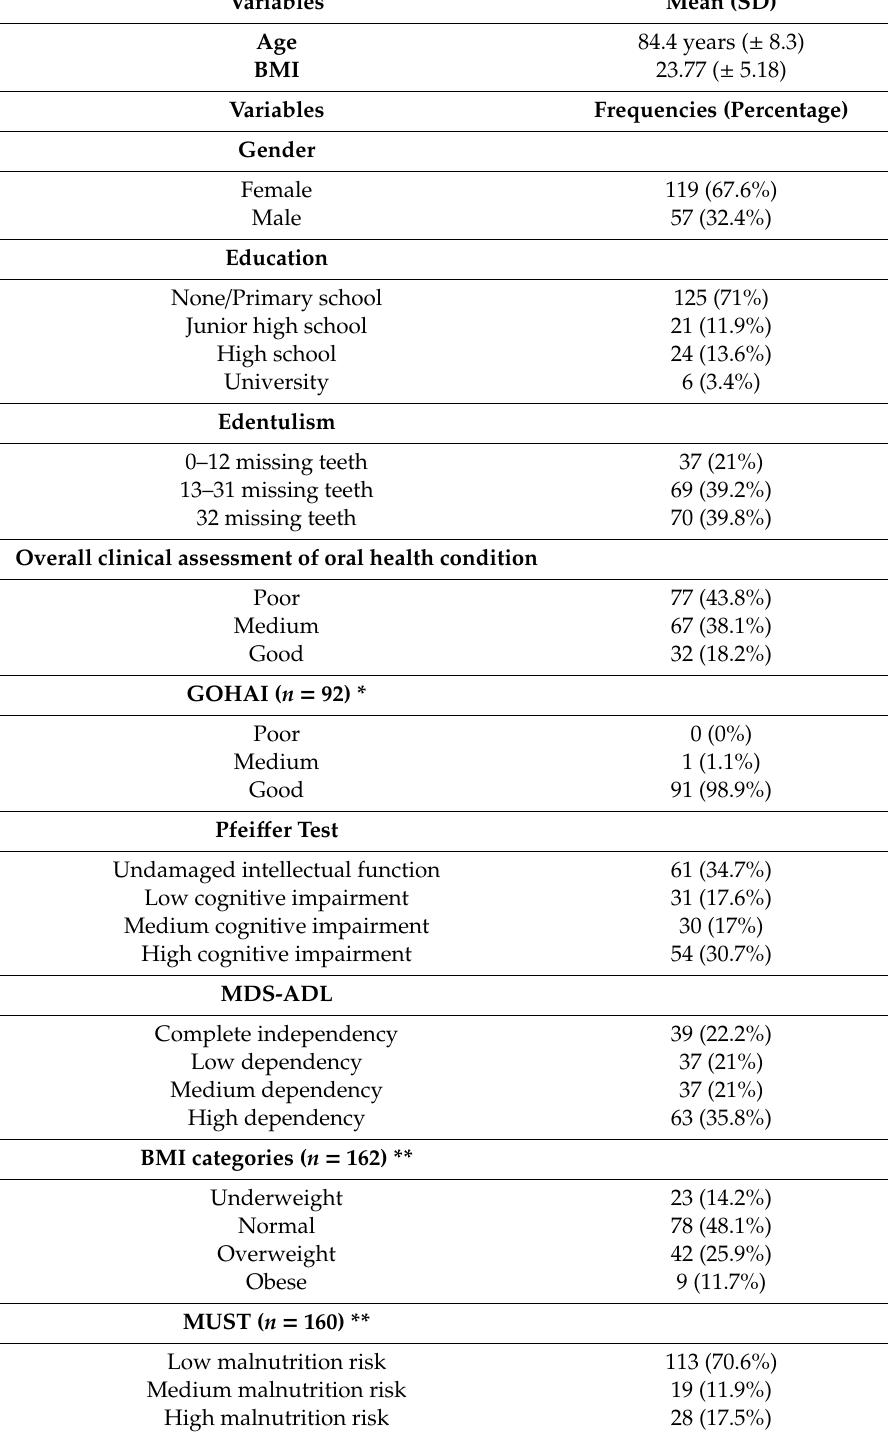
Table 1. The descriptive analysis of variables in a study of oral health in nursing homes in Florence, Italy, October 2017–October 2018 ( n =